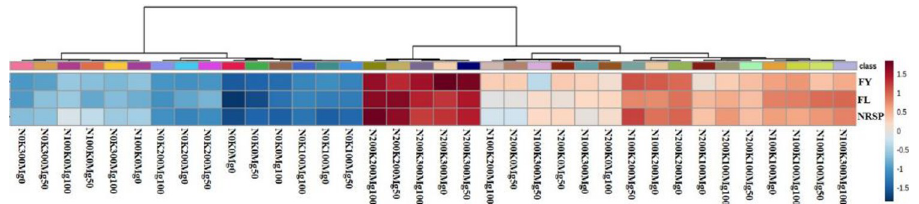
Fig 3. Heatmap clustering of the interactions effects among the three chemical fertilizers including N (0, 100, and 200 g), K (0, 100, 200, and 300 g), and Mg (0, 50, and 100 g) on fruit yield (FY), fruit length (FL), and number of rows per spike (NRSP) of greenhouse banana. The color scales represent the values were normalized by Z-score ((value-mean value)/standard error) for each